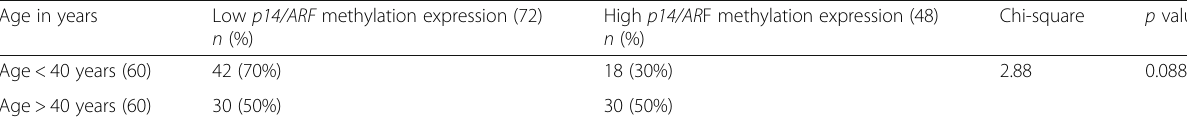
Table 5 Distribution of low and high p14/ARF methylation in the age subgroups Age in years Low p14/ARF methylation expression (72) High p14/AR F methylation expression (48) n (%) n (%)